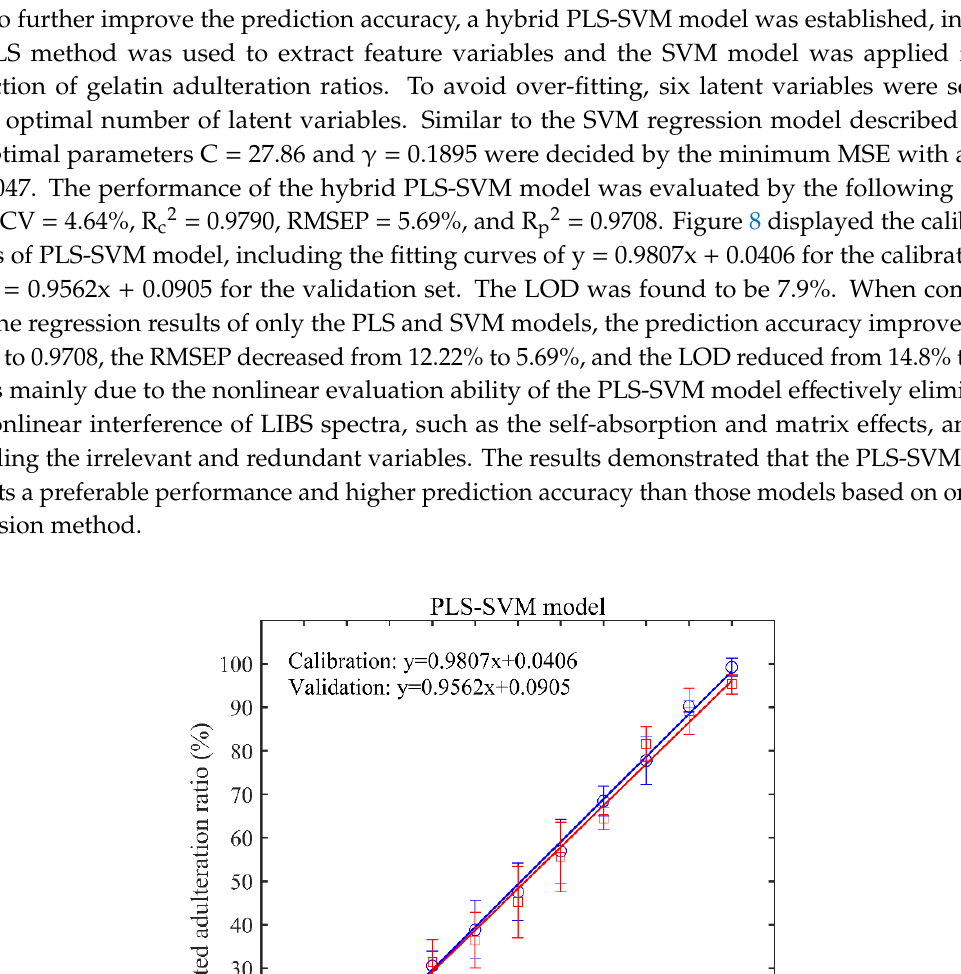
Table 3. Comparison of SVM models based on different variable selection methods. Model